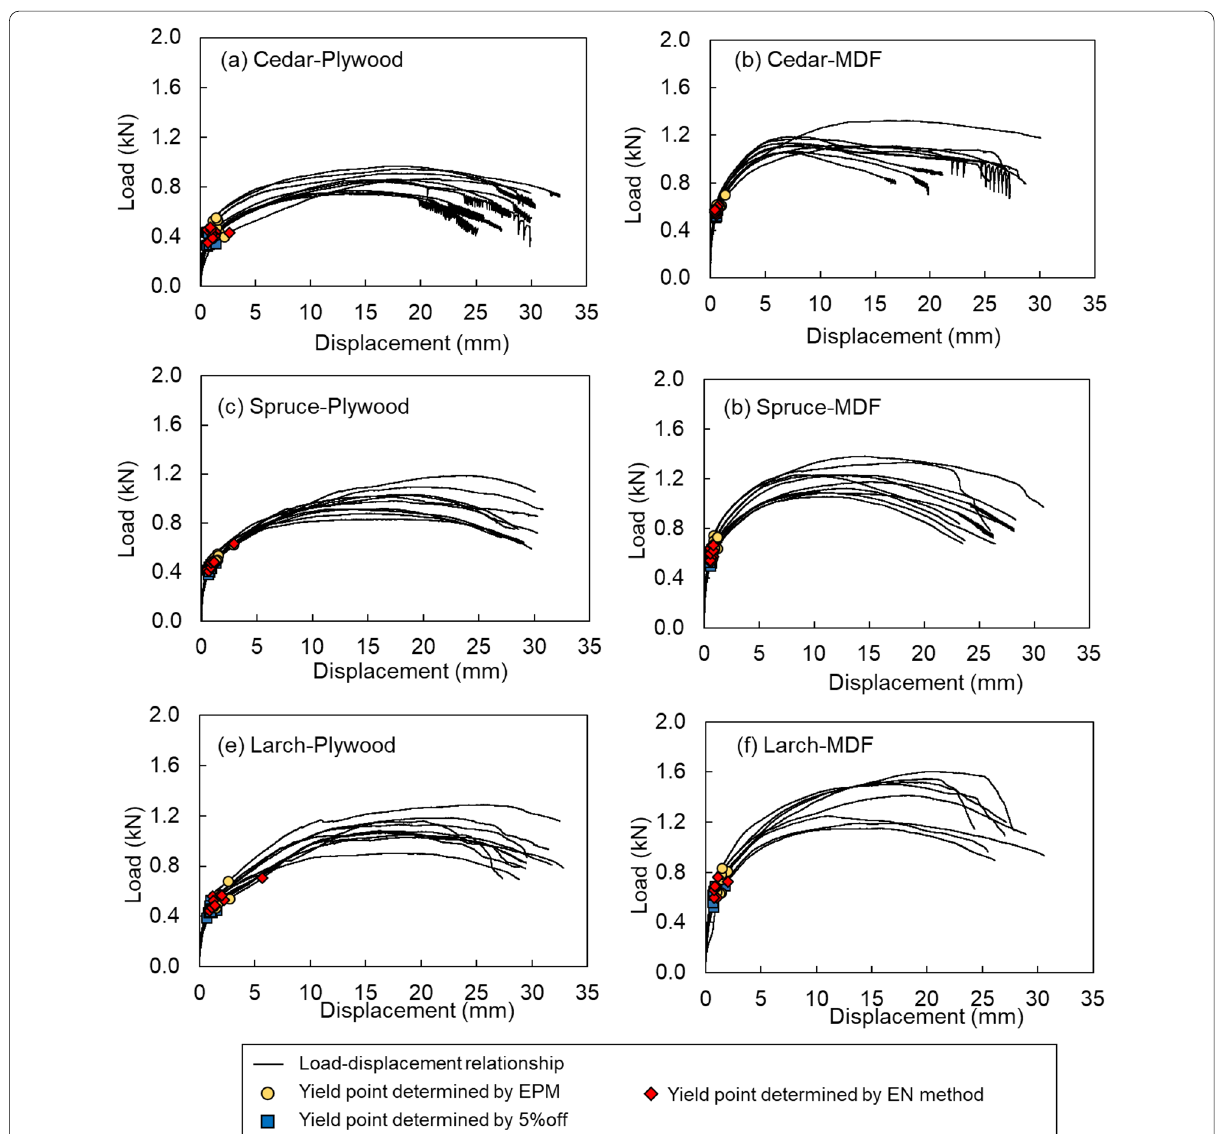
Fig. 5 Load–displacement relationships and yield points obtained via the monotonic loading test. The vertical axis indicates the load per a nail. The graphs were drawn for each specimen